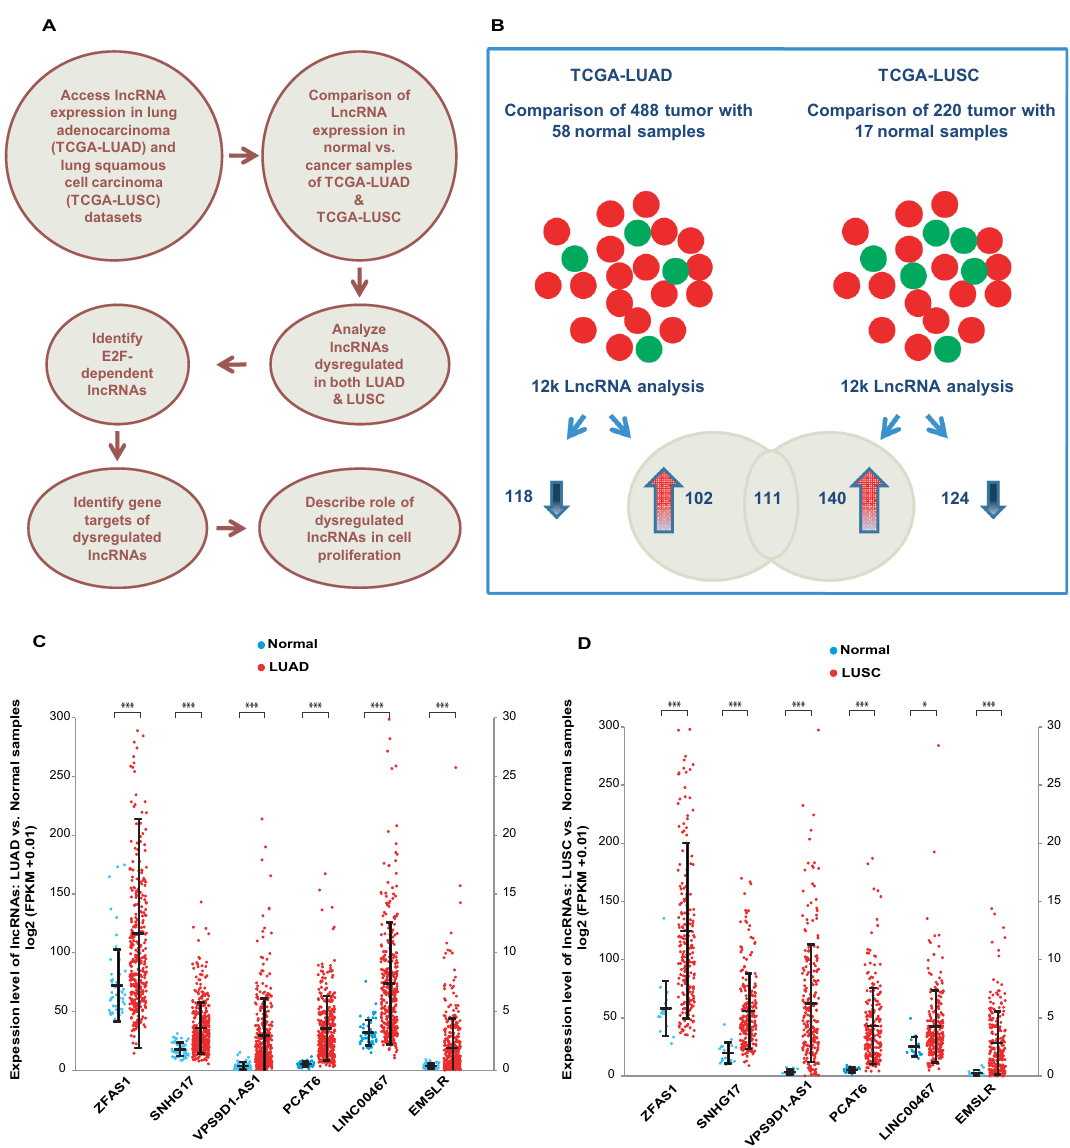
Figure 1. Transriptome analysis identifies EMSLR , an E2F1 -dependent lncRNA that is upregulated in TCGA- LUAD and TCGA-LUSC datasets. ( A ) Strategy used for the identification of E2F1 -dependent dysregulated lncRNAs in LUAD and LUSC, determination of their gene targets and their effect on cell proliferation and oncogenesis. ( B ) Comparison of transcriptional profiles identifies 111 lncRNAs upregulated in both LUAD and LUSC. The expression of around 12,000 lncRNAs was compared between 488 tumor and 58 normal samples of LUAD as well as 220 tumor and 17 normal samples of LUSC to identify upregulated (fold change > 2; upright arrow) or downregulated (fold change < 0.5; inverted arrow) lncRNAs. 111 lncRNAs that were upregulated in both cancers have been depicted by an intersecting Venn diagram. ( C ) From the 111 upregulated lncRNAs, 6 lncRNAs were selected which were previously reported to have effects on cell proliferation and oncogenesis. The plot displays the relative expression of the selected lncRNAs, namely ZFAS1 , SNHG17 , VPS9D1-AS1 , PCAT6 , LINC00467 and EMSLR in 488 tumor and 58 normal samples of LUAD dataset. Each point refers to the levels of selected lncRNAs in one sample, whereas long and short horizontal bars represent the mean and S.D., respectively. Due to exceptionally high expression of ZFAS1 , its log 2 FPKM values has been plotted with respect to the left vertical axis (range from 0–300), while the other lncRNAs have been plotted with respect to the right vertical axis (range from 0–30). p values calculated using Student’s t test display that expression of the selected lncRNAs is significantly different in LUAD samples compared to their respective normal samples (* p < 0.05; ** p < 0.01, *** p < 0.001). ( D ) Relative expression of the selected lncRNAs in 220 tumor and 17 normal samples of LUSC dataset. Details are same as part ( C